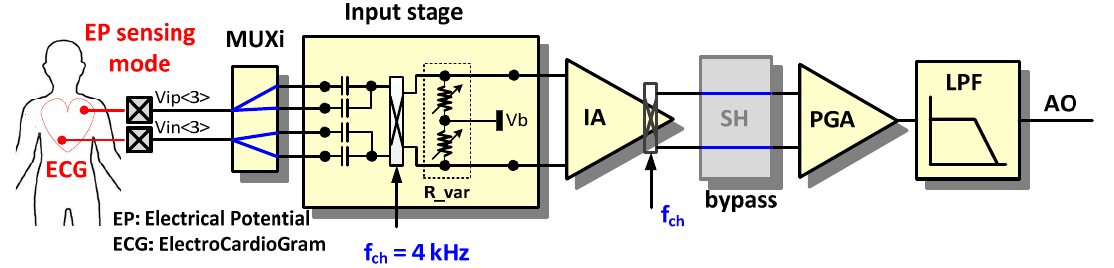
Figure 5. Reconfiguration of the readout channel for EP sensing mode.